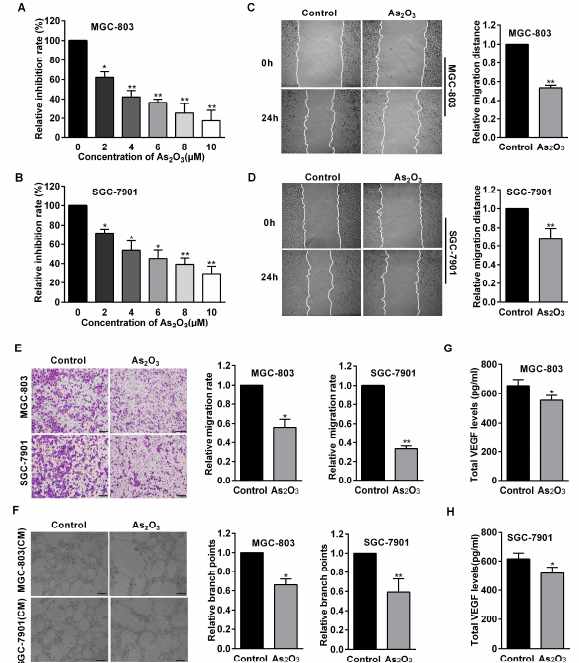
Figure 1. The effects of As 2 O 3 on gastric cancer cell viability, migration, and angiogenesis. ( A , B ) Cell Counting Kit-8 assays were used to measure cell viability in MGC-803 and SGC-7901 cells treated with different concentrations of As 2 O 3 for 24 h. ( C , D ) Wound healing assays were used to detect migration distances of these cells treated with As 2 O 3 for 24 h (100×). The quantification of migration rates was analyzed, respectively. ( E ) Transwell assay were performed to measure cell migration in gastric cancer cells treated with As 2 O 3 . The quantification of migration cells was performed. Scale bar, 100 µ m. ( F ) Tube formation assays detected formed tubes of Human umbilical vein endothelial cells (HUVECs) treated with conditioned medium. Calculating branch points per field was used to quantify the ability of tube formation. Scale bar, 100 µ m. ( G , H ) ELISA analysis detected VEGF protein secretion. All data were obtained from three independent experiments. Compared with the control group, * p < 0.05, ** p <